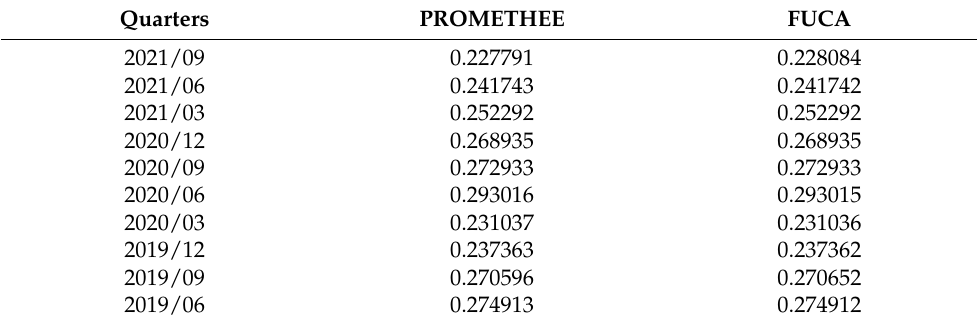
Table 13. Comparison Results for Significance Levels of PROMETHEE II and FUCA by SD Values in 10-Quarters (2019–2021).